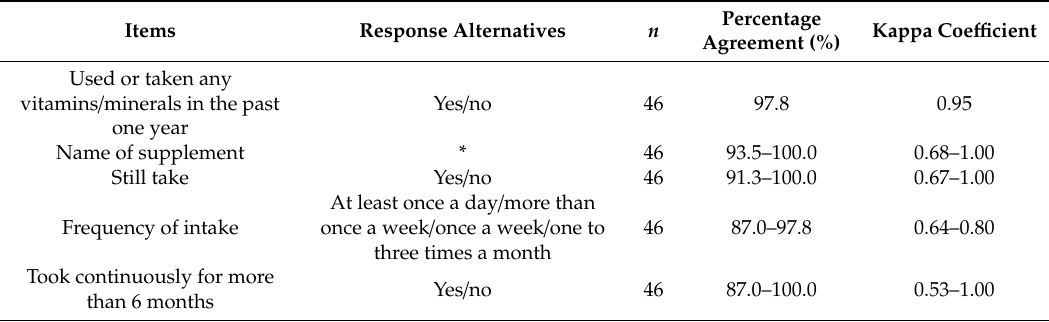
Table 3. Cohen’s kappa ( k ) coe ffi cient for the vitamin / mineral (VM) supplement consumption.